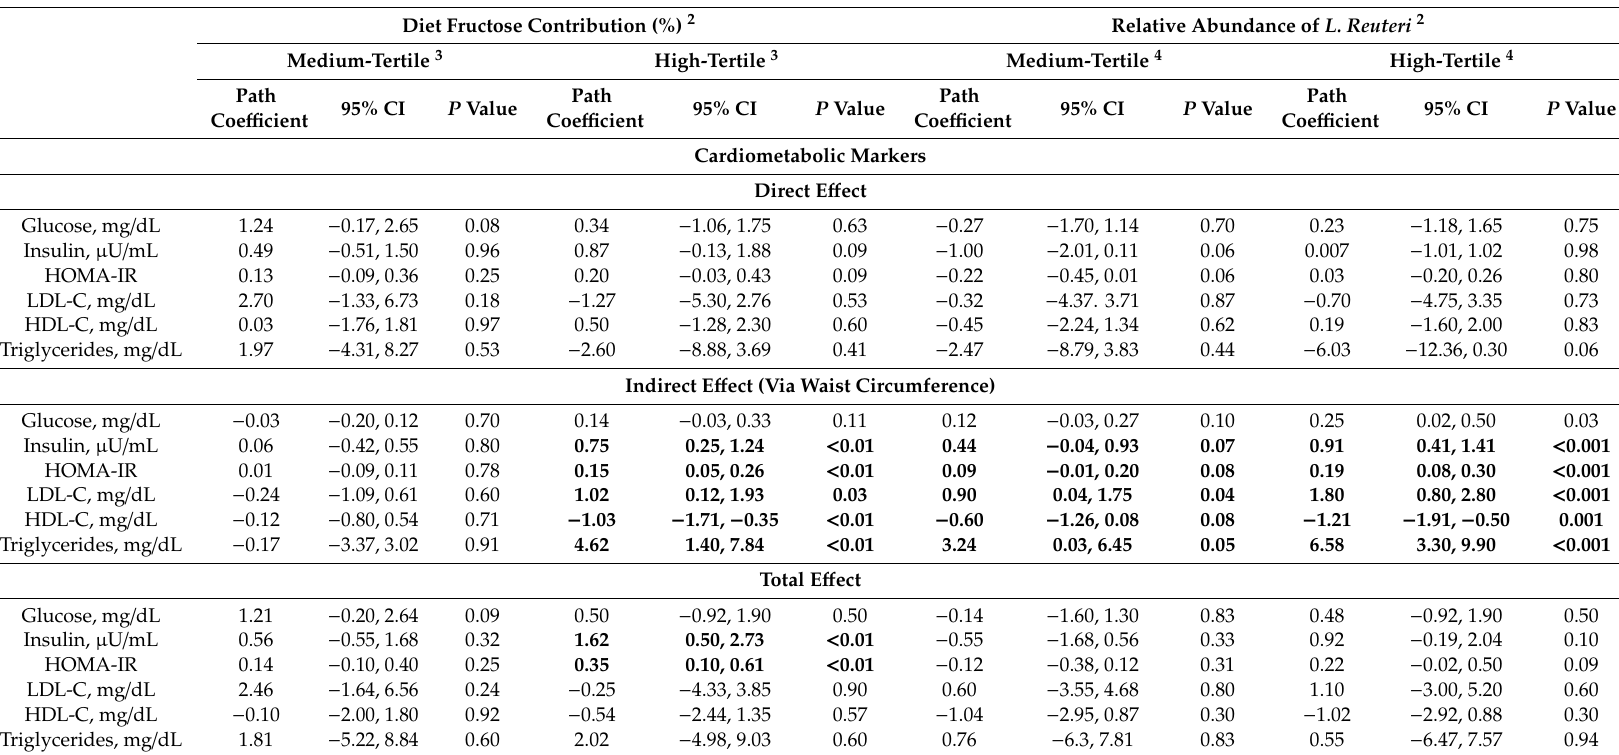
Table 3. Direct and indirect e ff ects of L. reuteri RA and diet fructose contribution on cardiometabolic markers in children of Mexico City 1